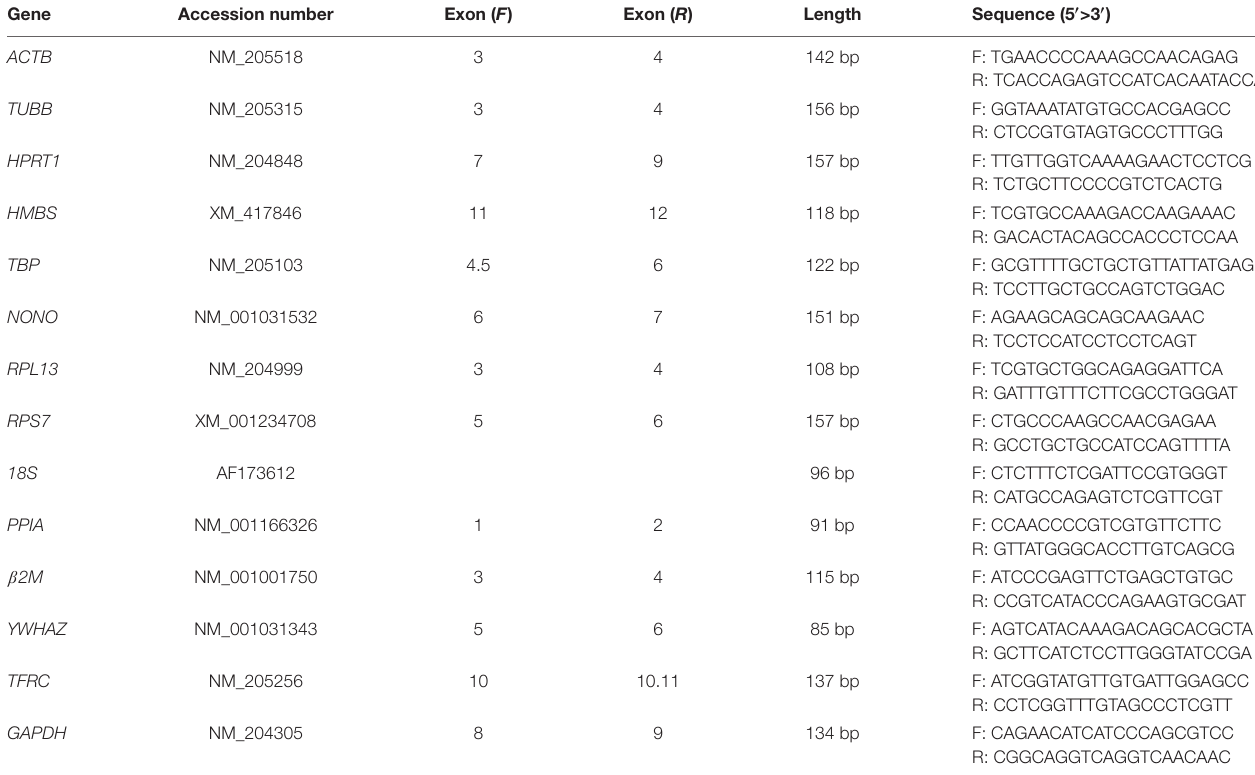
TABLE 2 | Primer sequences of 14 selected internal control genes.